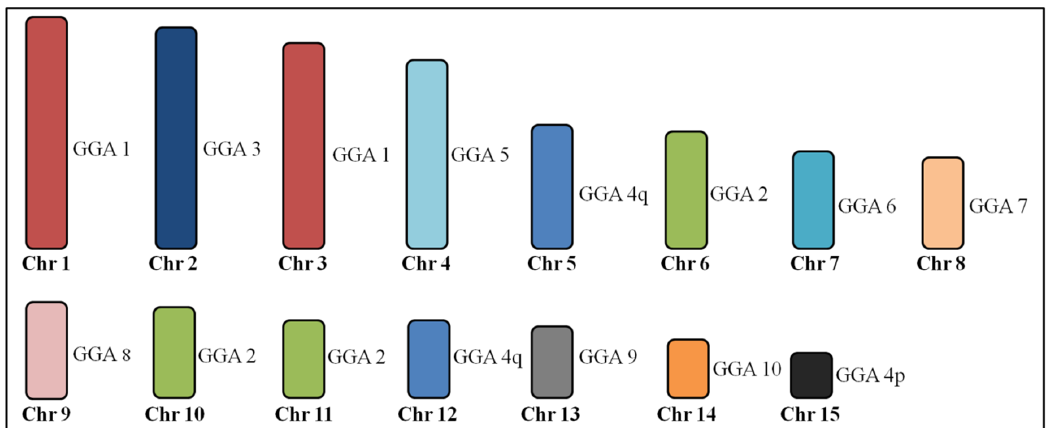
Figure 4. Homologous chromosomal segments of Gallus gallus (GGA) in Geotrygon violacea and Geotrygon montana macrochromosomes as detected by fluorescence in situ hybridization (FISH) using GGA and Zenaida auriculata whole chromosome paints.